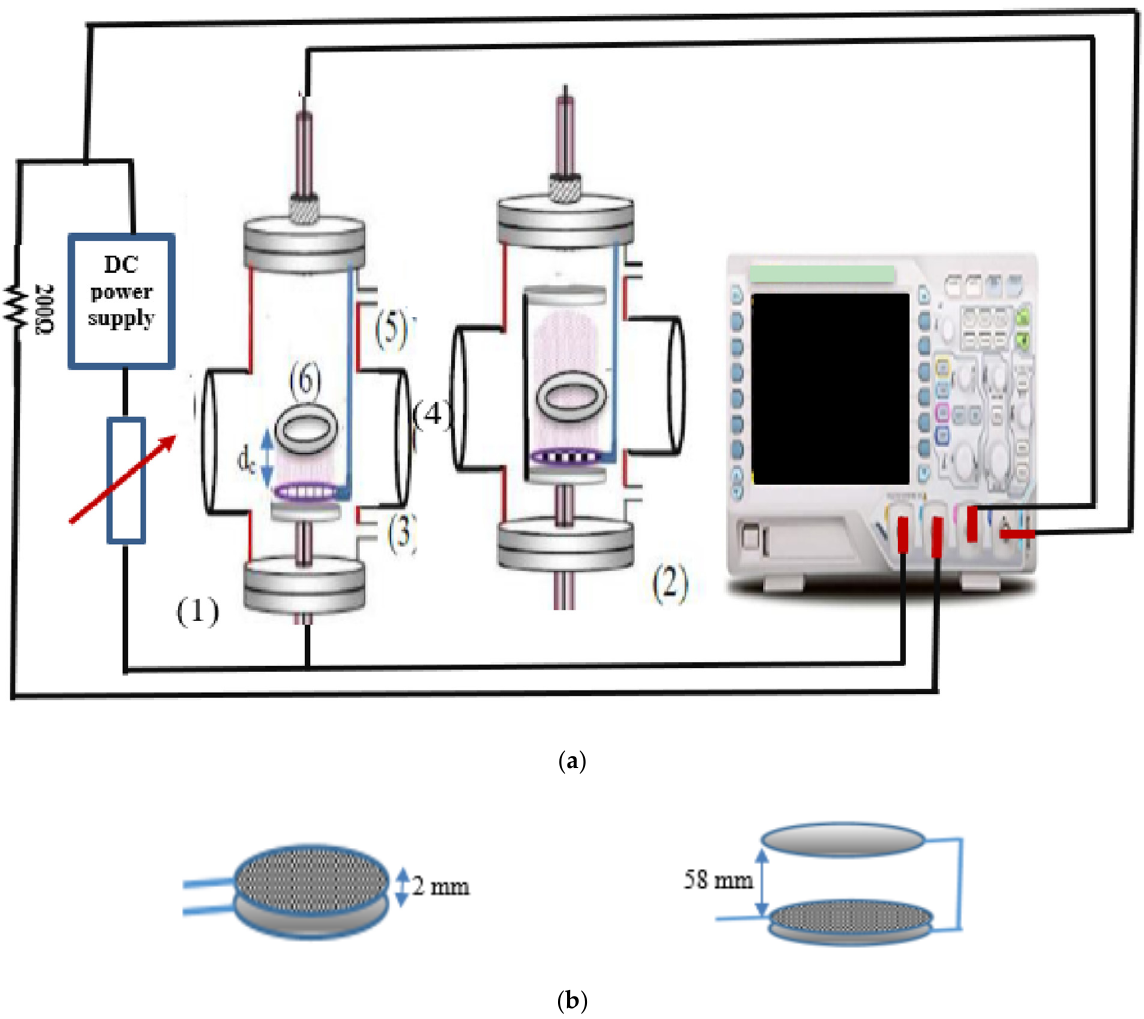
Figure 1. ( a ) Schematic diagram of the experimental set-up of the evacuated chamber containing ( 1 ) the OMSE reactor, ( 2 ) the OMTSE reactor, ( 3 ) gas inlet, ( 4 ) window, ( 5 ) rotary pump, and ( 6 ) sample holder over the cathode fall region dc. ( b ) System 1, OMSE reactor ( left ), and System 2, OMTSE reactor ( right ).